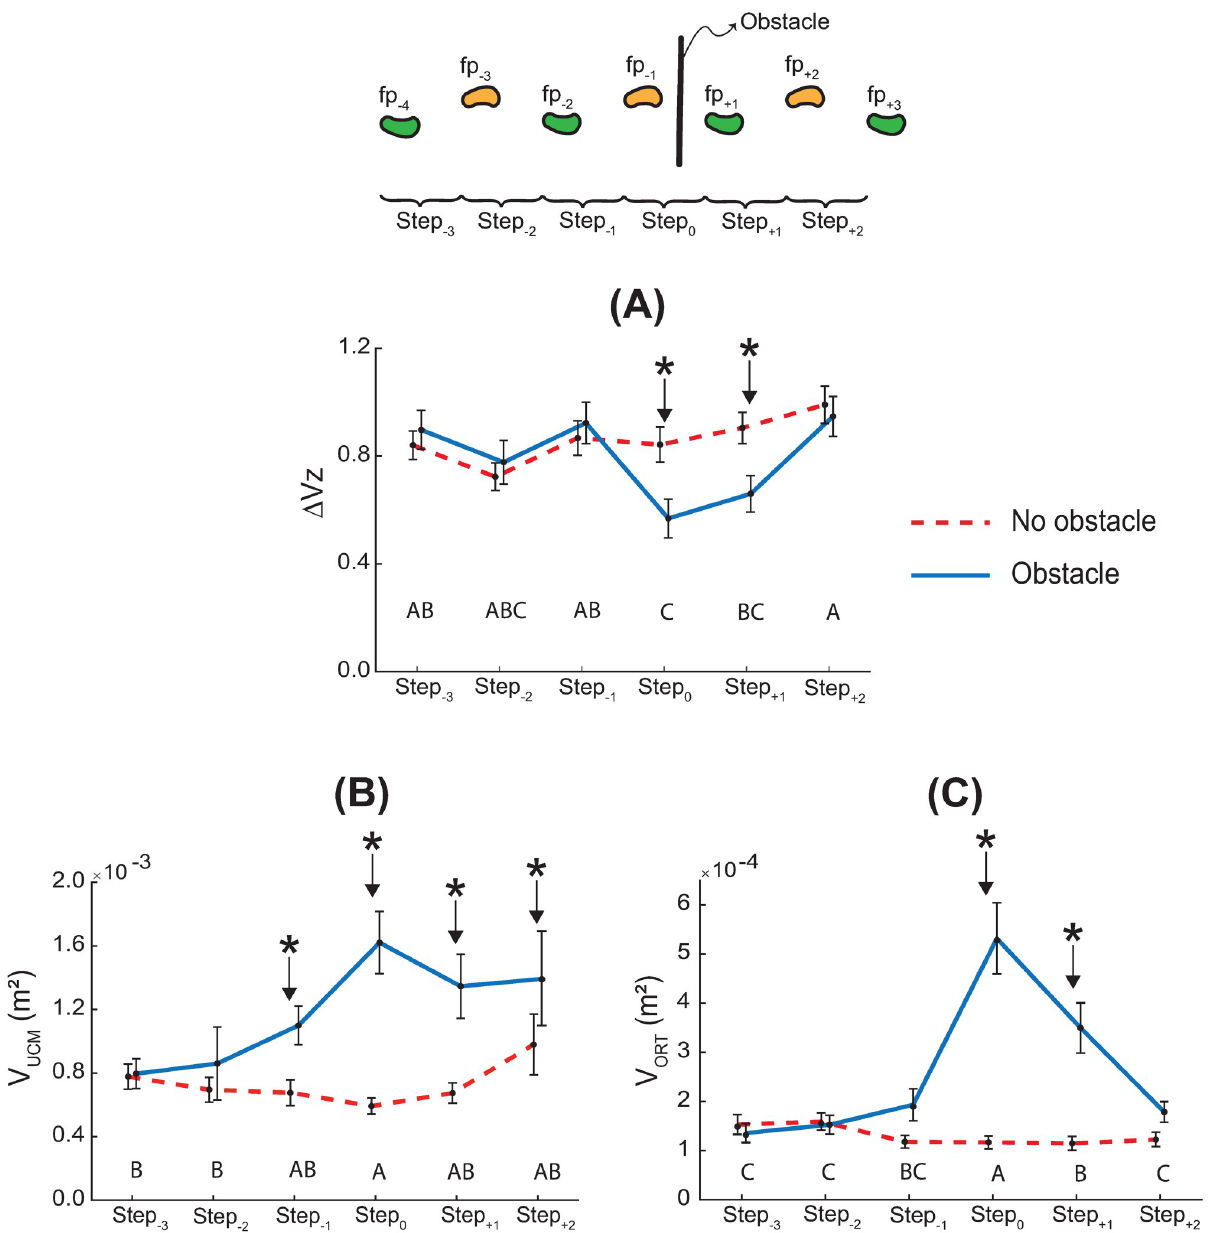
Fig 4. Outcomes of the synergy analysis. Synergy index (A) , V UCM (B) , and V ORT (C) . Data are across-subject means (N = 20), and error bars denote standard error. Asterisks denote significant across-task differences at that step (p < 0.05). Across-step pairwise comparisons for the obstacle-crossing task are indicated by the row of letters above the horizontal axis for each panel. Steps that do not have letters in common are significantly different from each other (i.e., A is different from B, but A is not different from